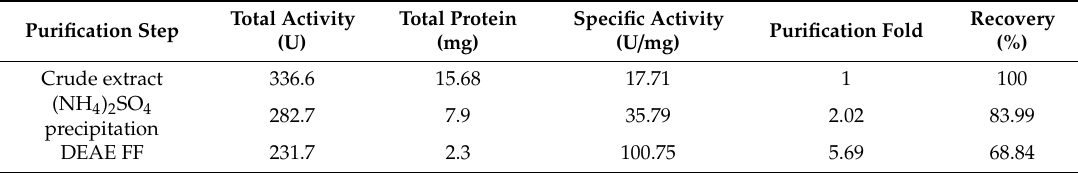
Table 1. Summary of rAga-ms-R purification from Brevibacillus culture